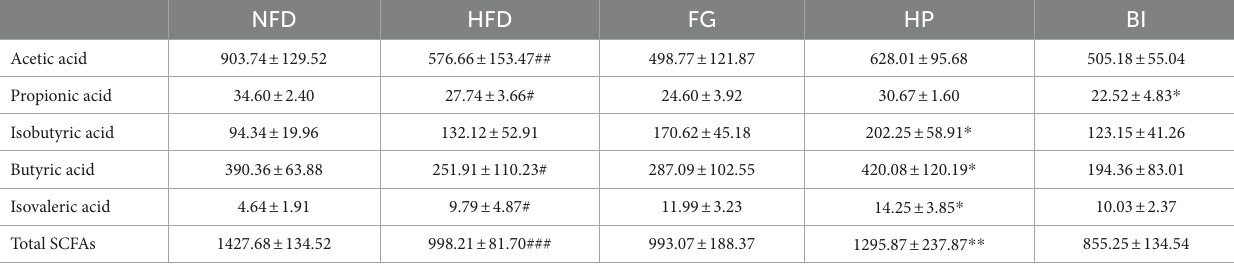
TABLE 2 The levels each kind of SCFAs of NFD, HFD, FG, HP, and BI